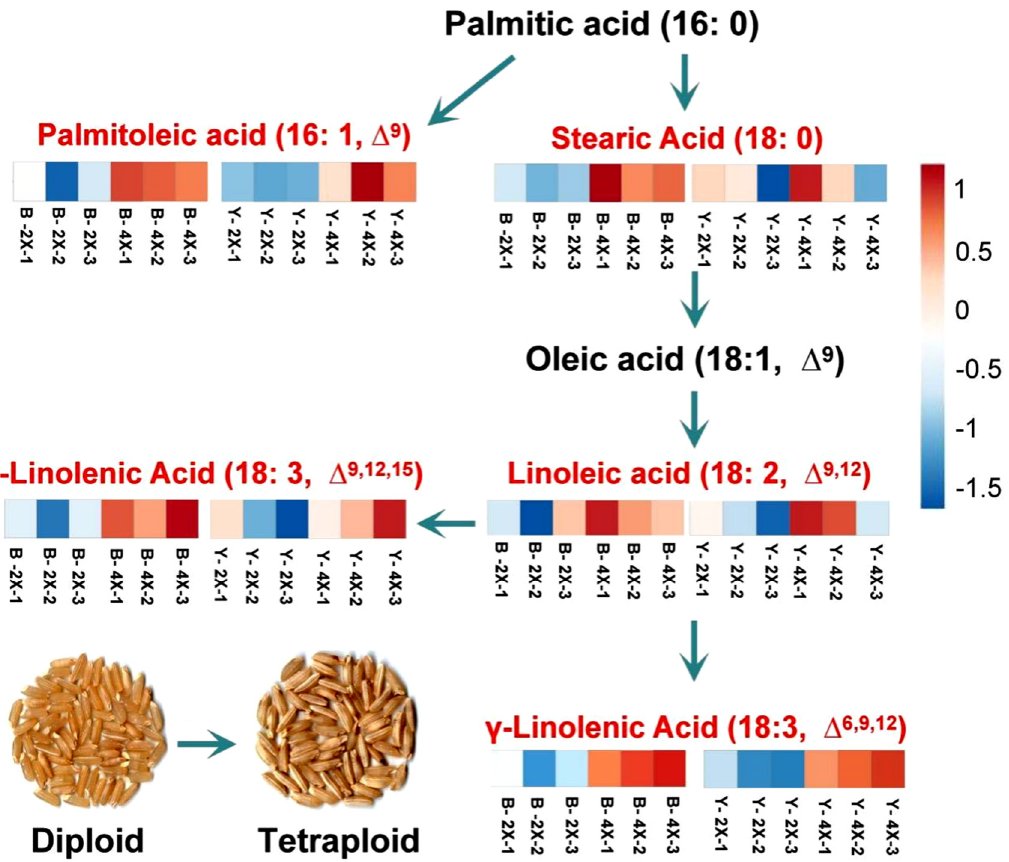
Figure 6. Schematic presentation of the pathway for certain unsaturated fatty acids metabolites as affected by polyploidization in rice. Red represents increases. The checkerboard is the heatmap of metabolites for the diploid vs. tetraploid groups. Ratios of fold changes are given by shades of red or blue color according to the scale bar.